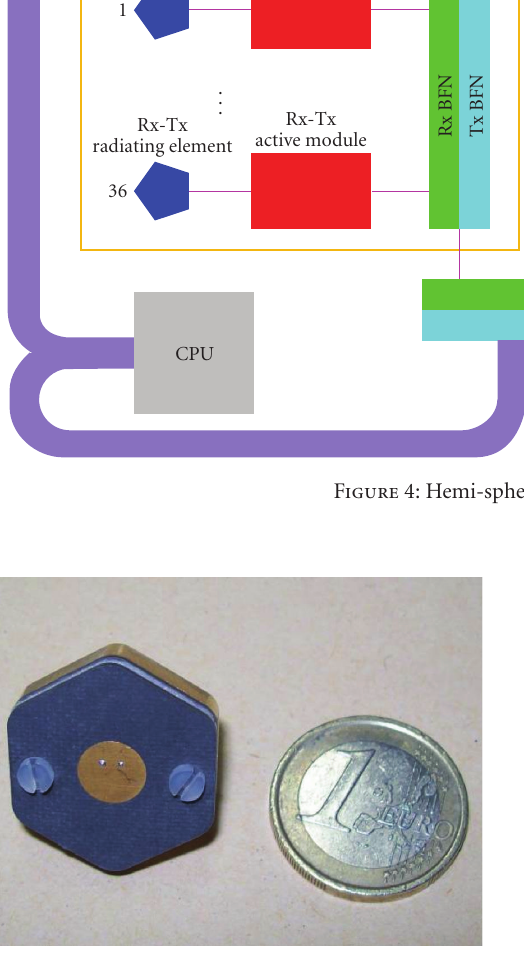
Figure 5: Radiating element prototype.